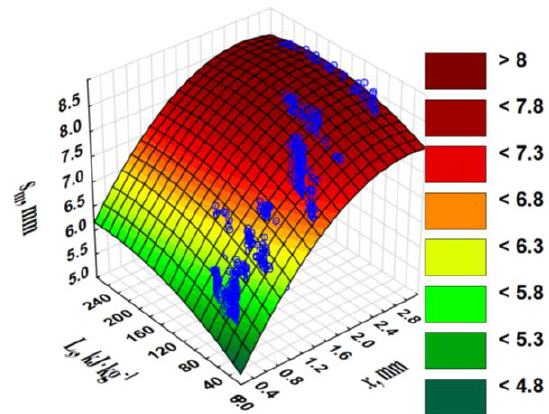
Figure 3. Piston displacement s m vs. fraction particle size x and specific compaction work L s .